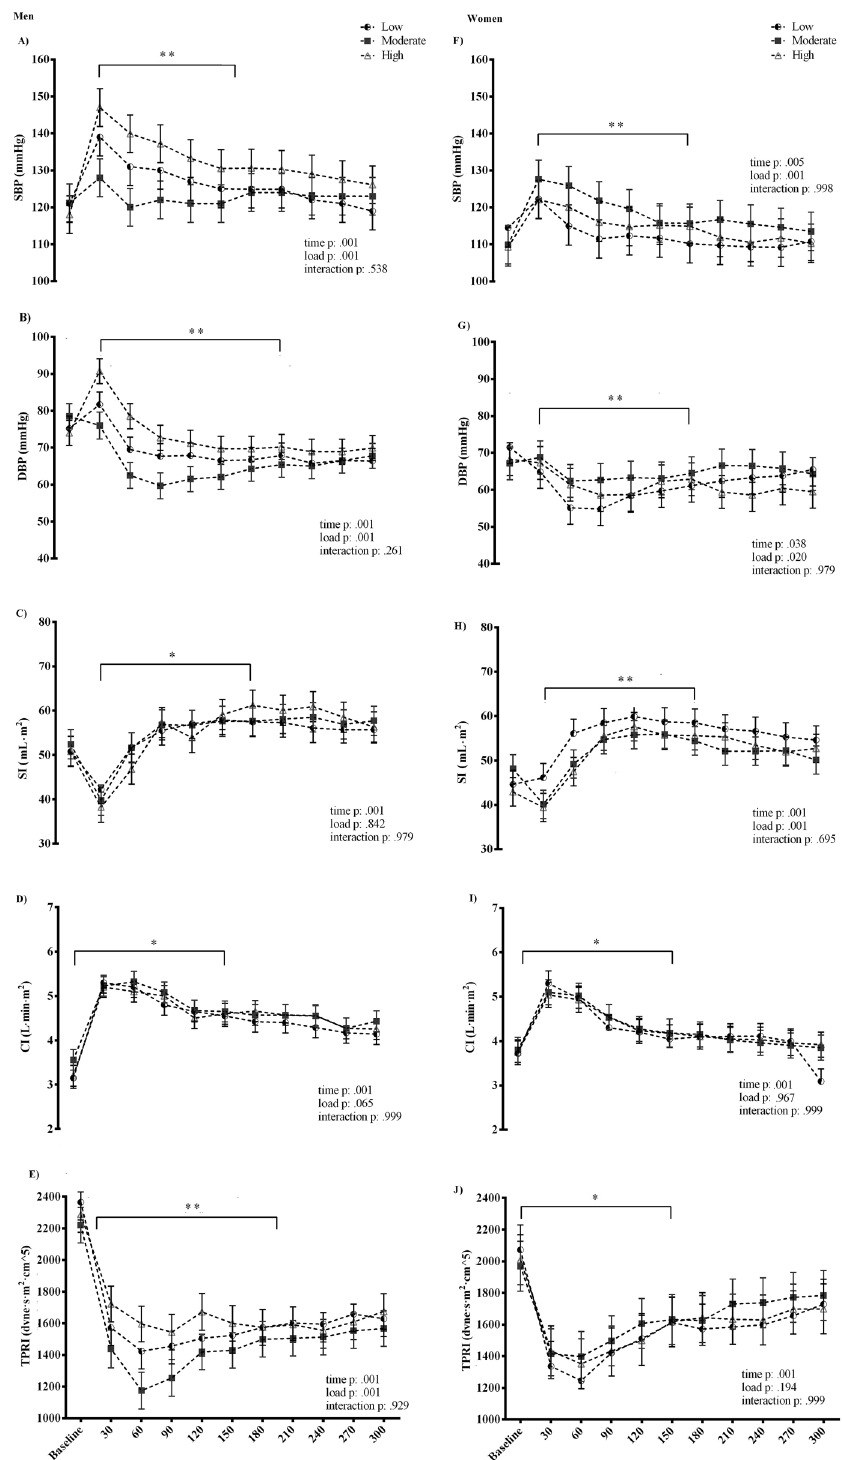
Figure 3. Cardiovascular response after the flywheel exercise with different load. SBP systolic blood pressure, DBP diastolic blood pressure, SI stroke index, CI cardiac index, TPRI total peripheral resistance index. *Time effect. **Load effect. ***Interaction